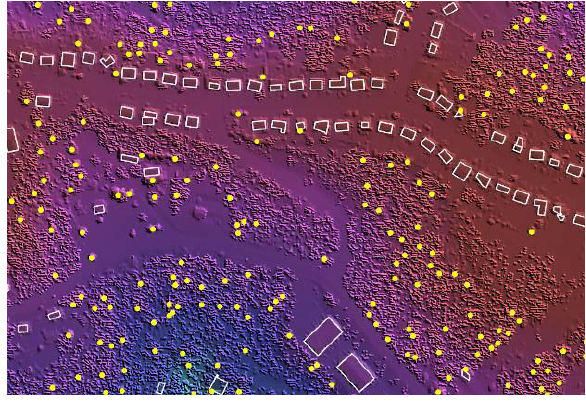
Figure 6. Buildings, houses, and trees at 1:1 resolution.